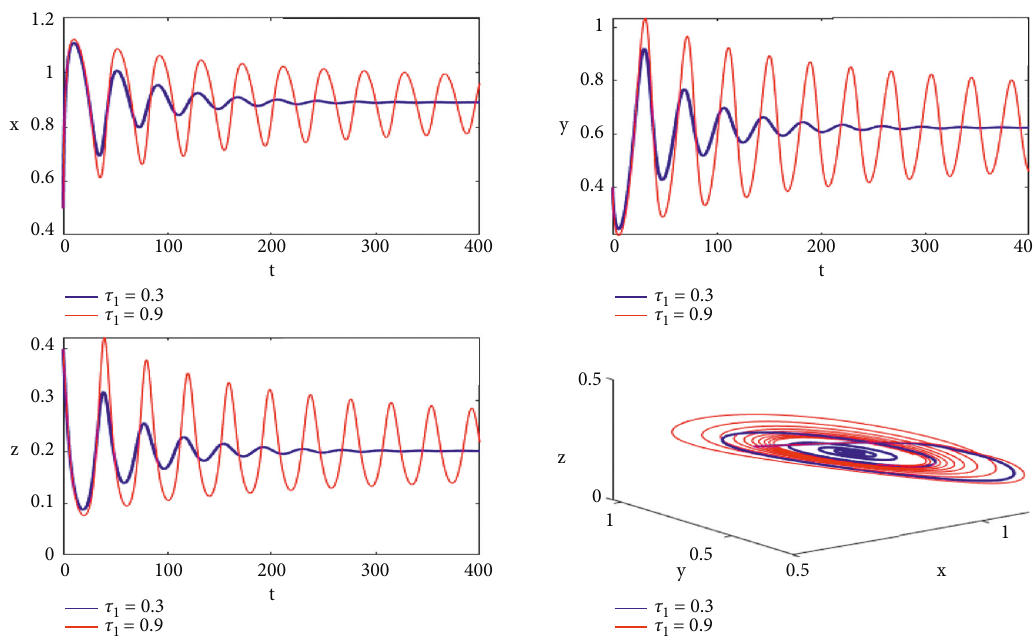
Figure 4: Case 2: the trajectories and phase diagrams of system (92) over time at τ